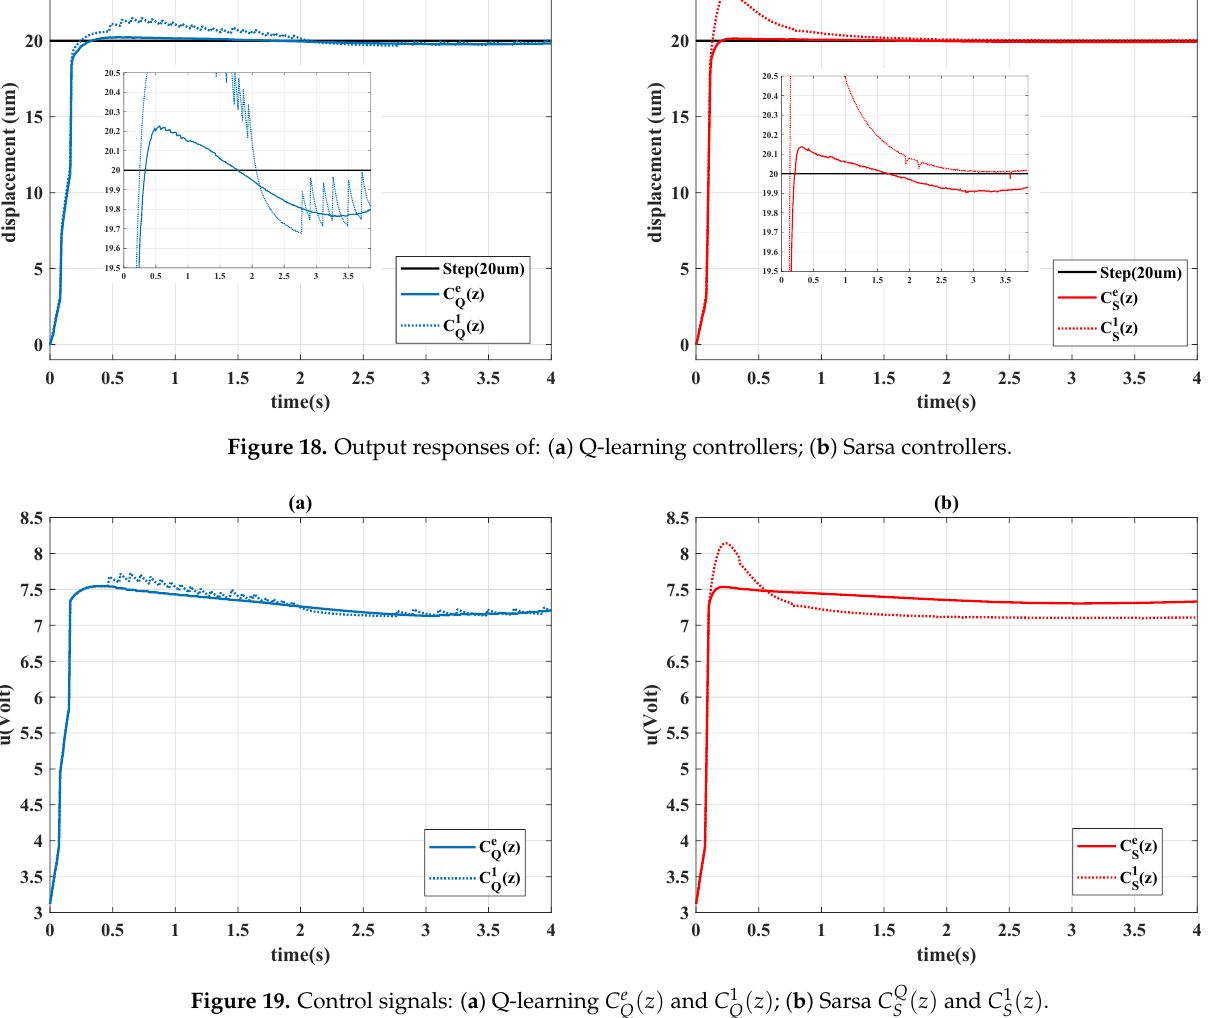
Figure 19. Control signals: ( a ) Q-learning C e